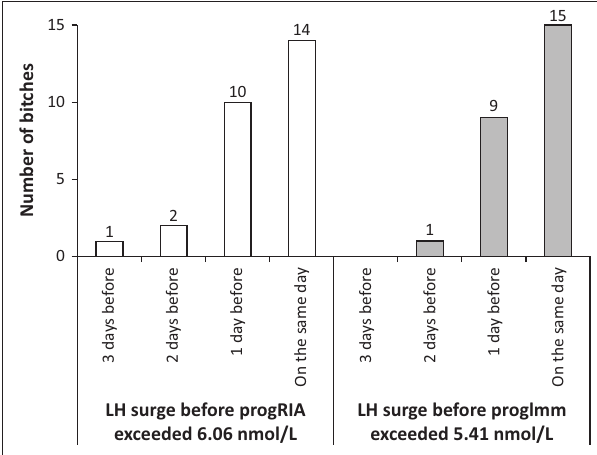
FIGURE 1: Days – relative to the day on which the concentration of progesterone measured with Coat-A-Count® radioimmunoassay in the plasma of bitches first exceeded 6 nmol/L – on which the concentration measured in their serum with Immulite® 1000 LKPW1 (ProgImm) first exceeded 6 nmol/L or its predicted value of 5.1 nmol/L.